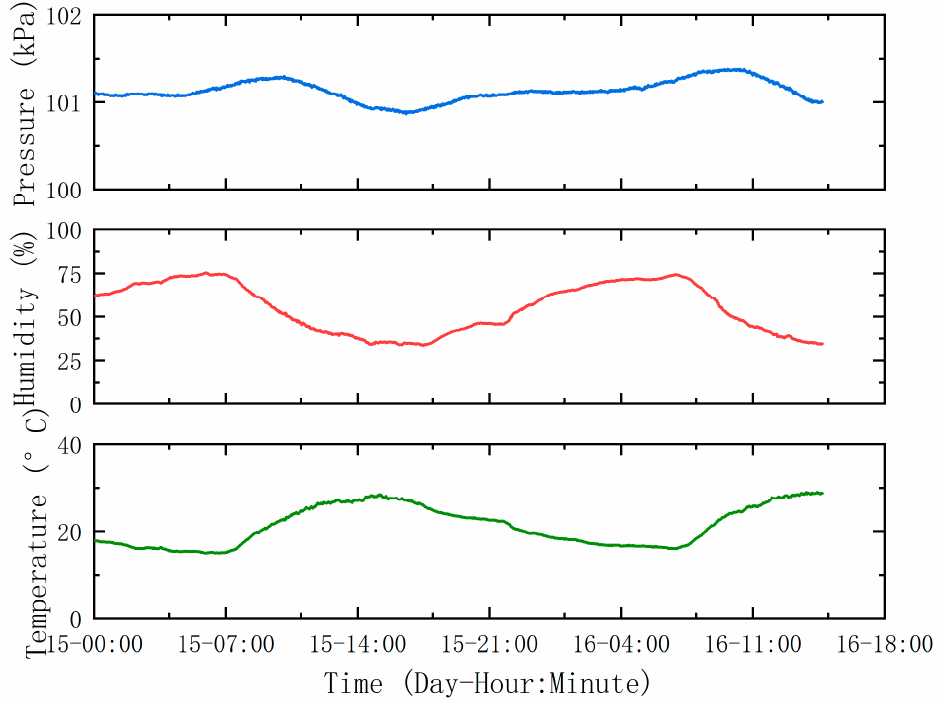
Figure 10. The time series of pressure, humidity, and temperature at a meteorological data collector from 15 October 2022 to 16 October